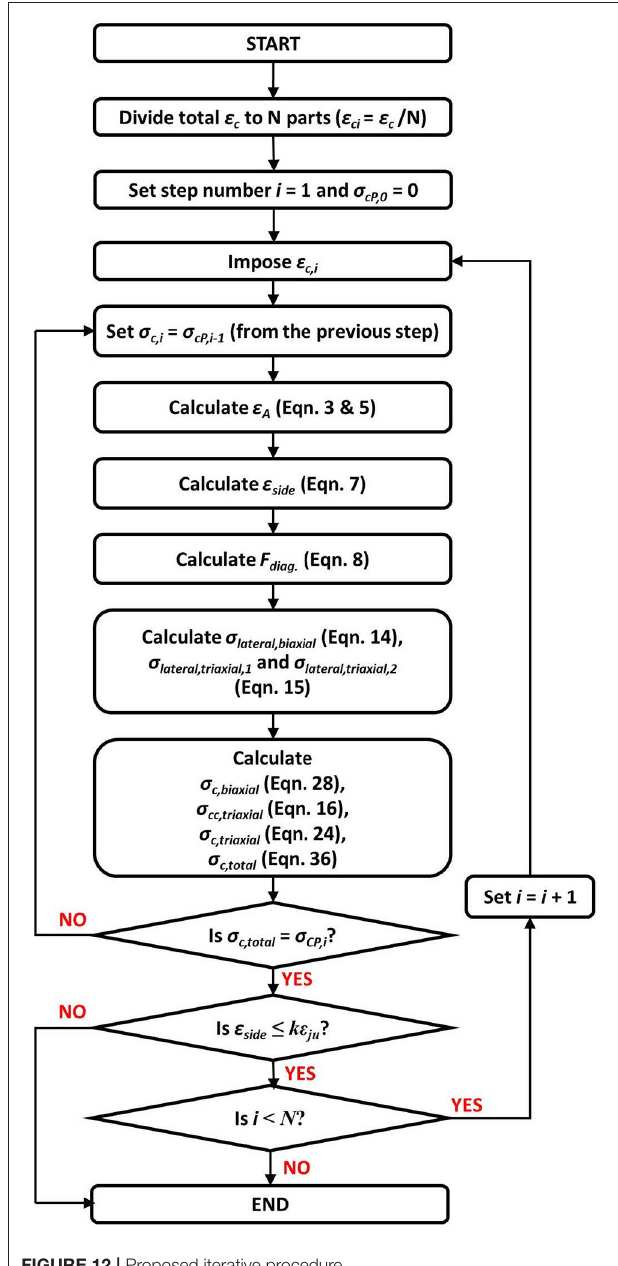
FIGURE 12 | Proposed iterative